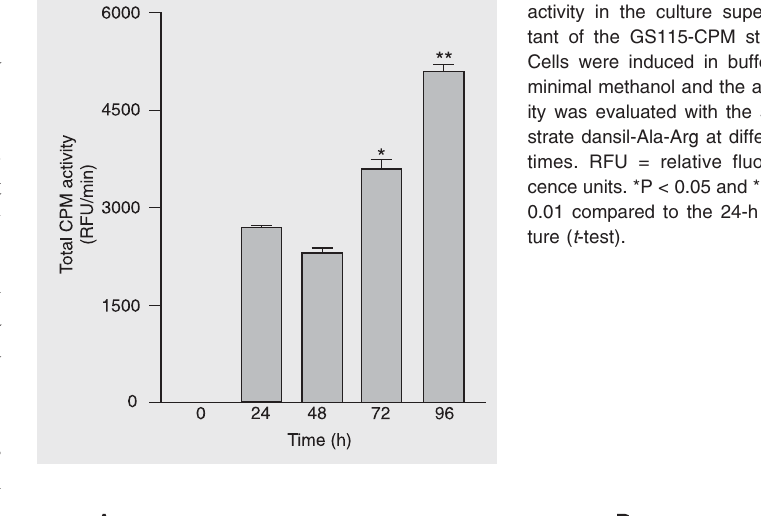
Figure 1. Expression of recom- binant hCPM in the control and transformed (hCPM) clones of Pichia pastoris 24 h after inocu- lation into buffered glycerol- complex medium. The yeast cells (y) and the supernatant (s) were separated by centrifuga- tion and assayed for CPM activ- ity with dansil-Ala-Arg as sub- strate. hCPM = human carbox- ypeptidase M; RFU = relative flu- orescence units. *P < 0.01 com- pared to the supernatant of the control clone ( t -test).